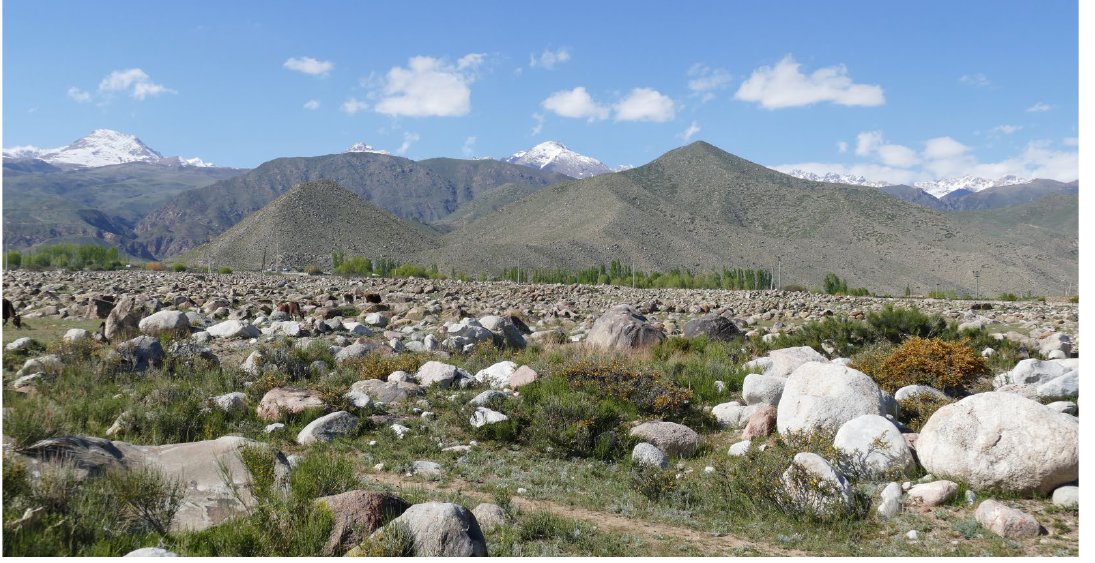
Figure 5. A stone field with petroglyphs in the museum near a village of Cholpon-Ata. Source: authors’ own.